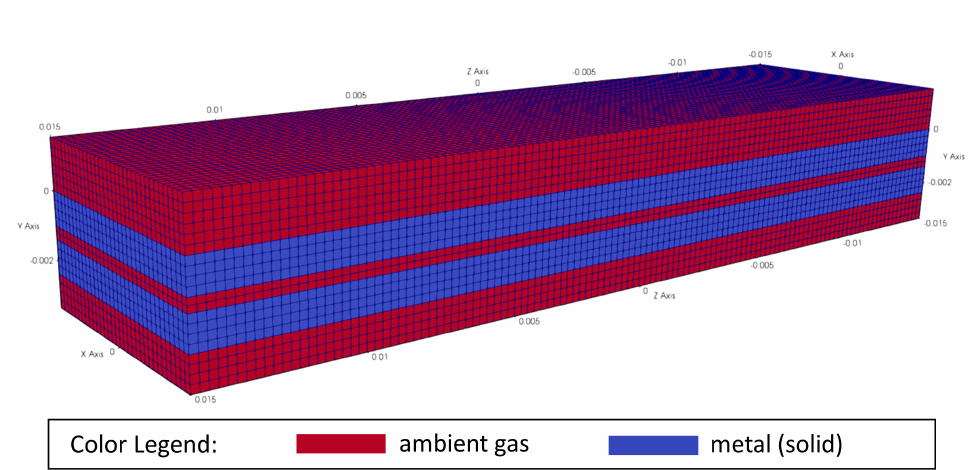
Figure 1. Spatial domain of the CFD model with initial (unrefined) computational grid; measurements in